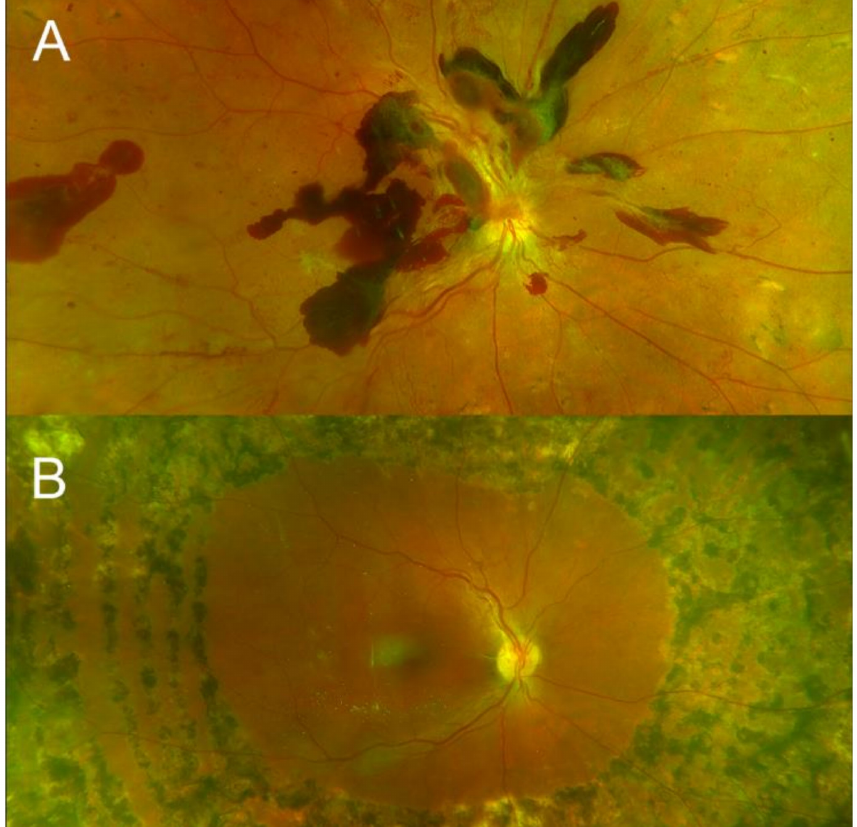
Figure 2. 22-year-old Caucasian female type 1 diabetic (diagnosed age 11). Top image ( A ) shows scattered retro-cortical hemorrhage in the posterior pole from active neovascularization with inade- quate laser treatment. Bottom image ( B ) shows quiescent clinical disease following vitrectomy and endophotocoagulation. Visual acuity improved from count fingers to 20/40. (Images courtesy of Siva S.R. Iyer,